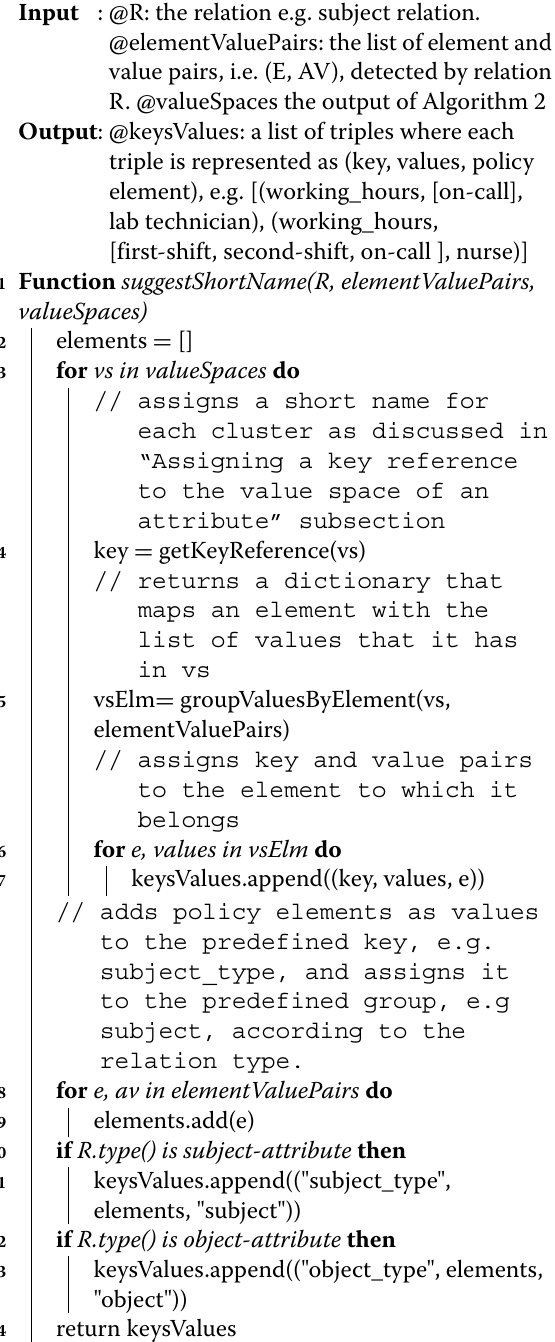
Algorithm 3: Assign a key reference to each value